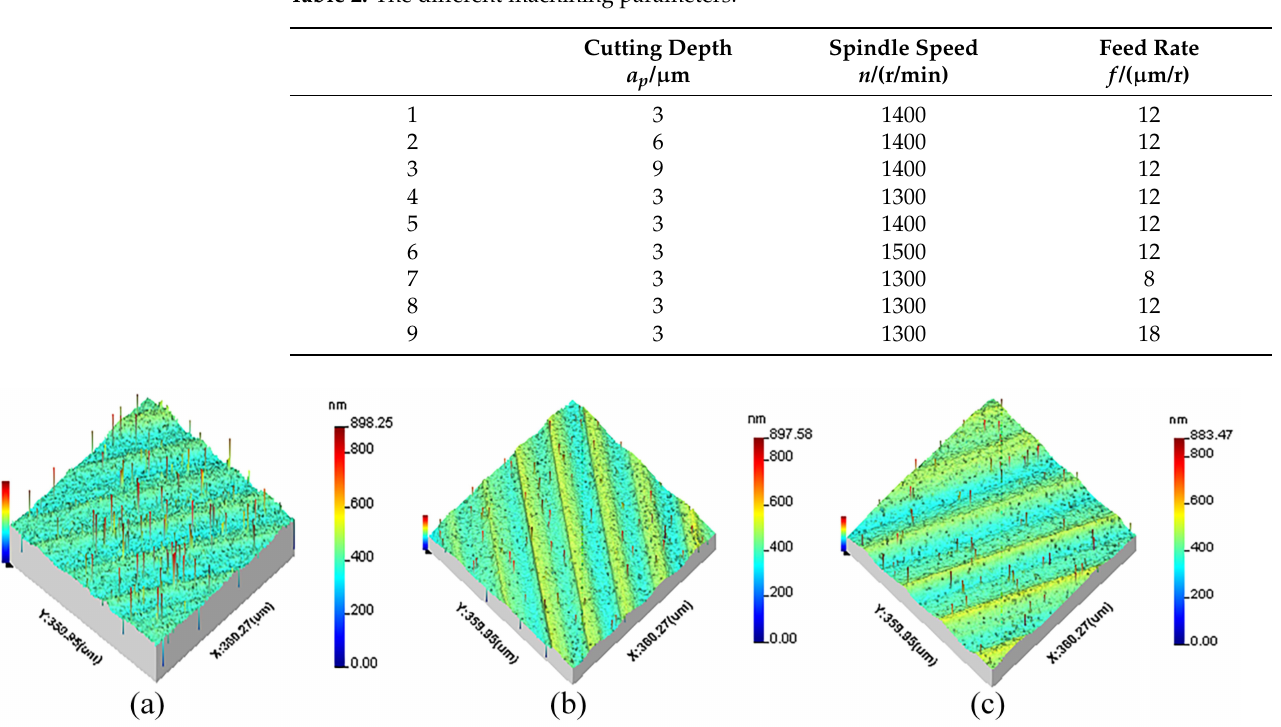
Table 2. The different machining parameters.